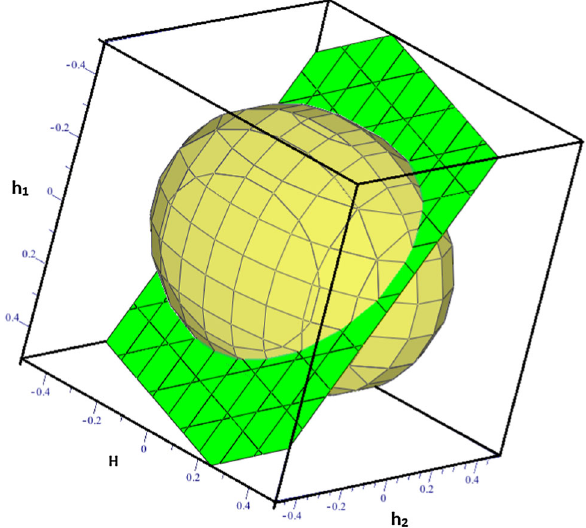
Fig. 6 The graphical representation (in Hubble-like variables H , h 1 , h 2 ) of intersection of plane (see (7.1)) and ellipsoid (see (7.2)) for m = 3, k 1 = 4, k 2 = 5 and α = 1